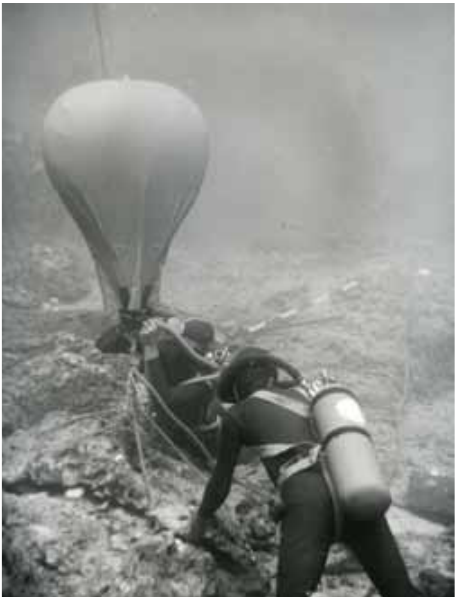
Fig. 2: Joan du Plat Taylor and Honor Frost pioneering underwater archaeology at Cape